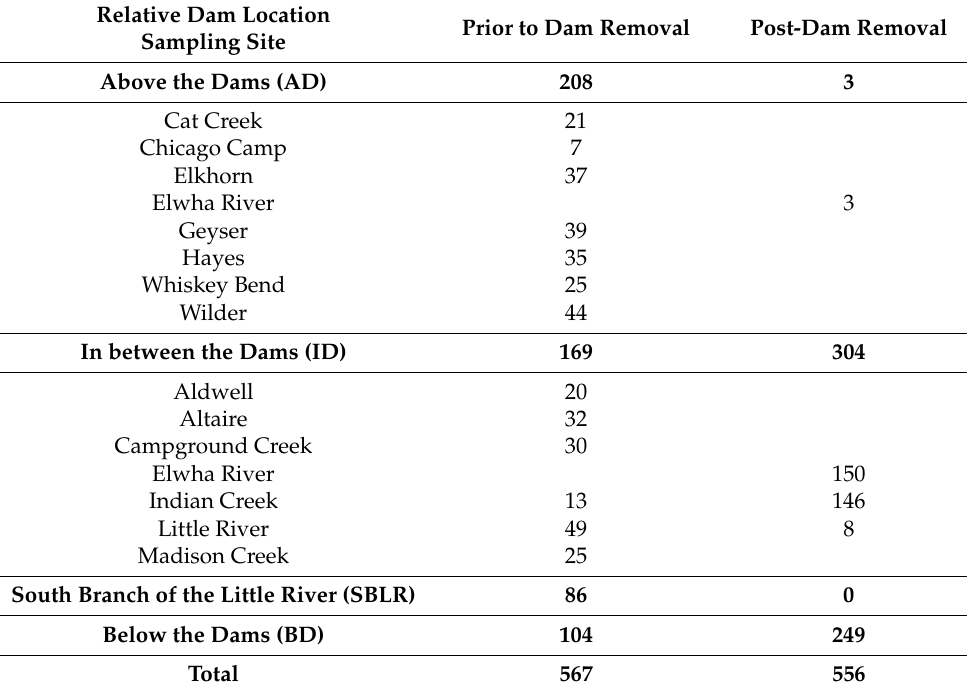
Table 1. All sequenced samples arranged by population (AD, ID, SBLR, and BD) and sampling site, or- dered from upstream (top) to downstream (bottom) divided by relative anadromous barrier